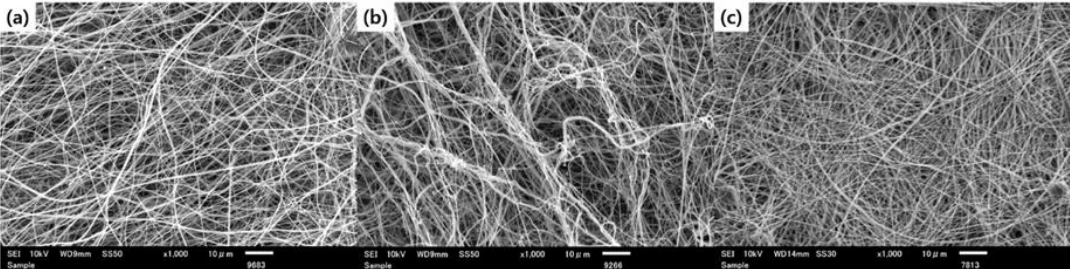
Figure 2. SEM images showing morphologies of ( a ) as-spun PEICT nanofiber, ( b ) PEICT/ZnO nanofibers without post-electrospinning treatment with ethanol, and ( c ) PEICT/ZnO composite nanofibers by post-electrospinning treatment with ethanol and subsequent loading of ZnO nanoparticles.